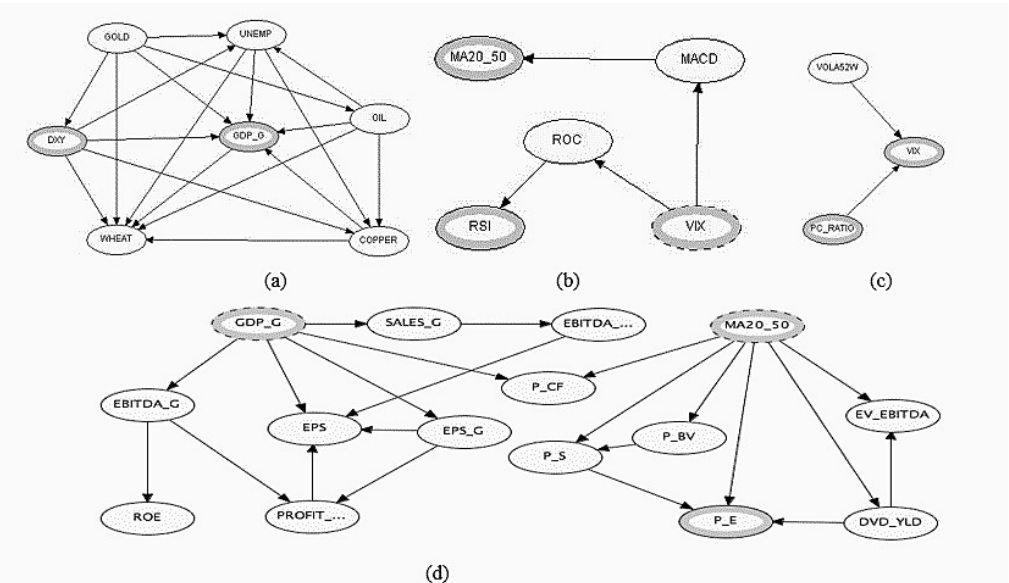
Figure 5. Unveiling the complexity in the S&P 500 drivers. From top to bottom and from left to right, the BN defining the ties among growth ( a ); momentum/technical analysis ( b ); sentiment ( c ); and value indicators ( d )